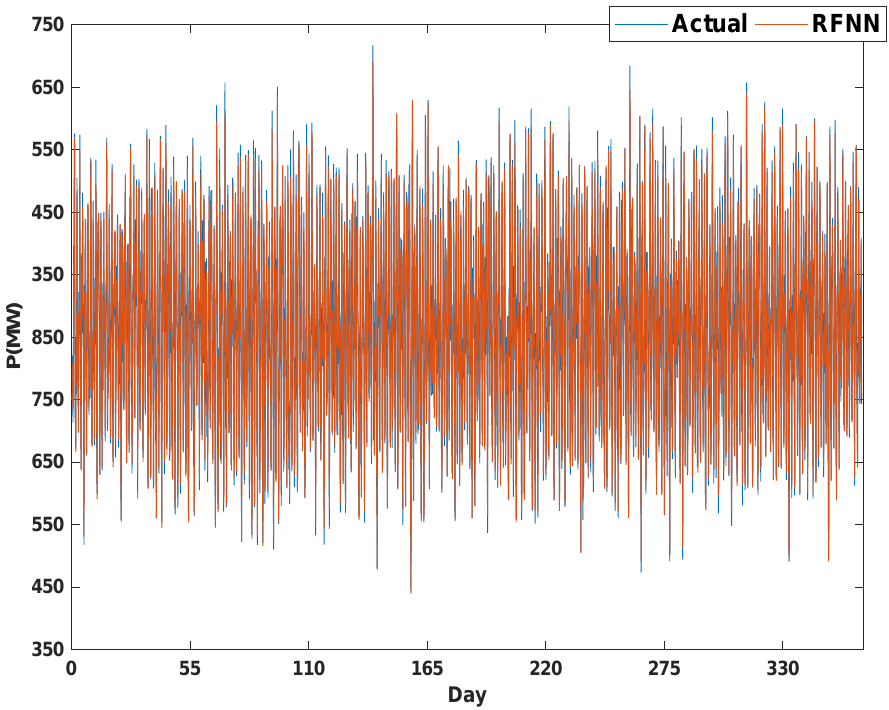
Figure 9. Neural network training results with yearly data (2018).